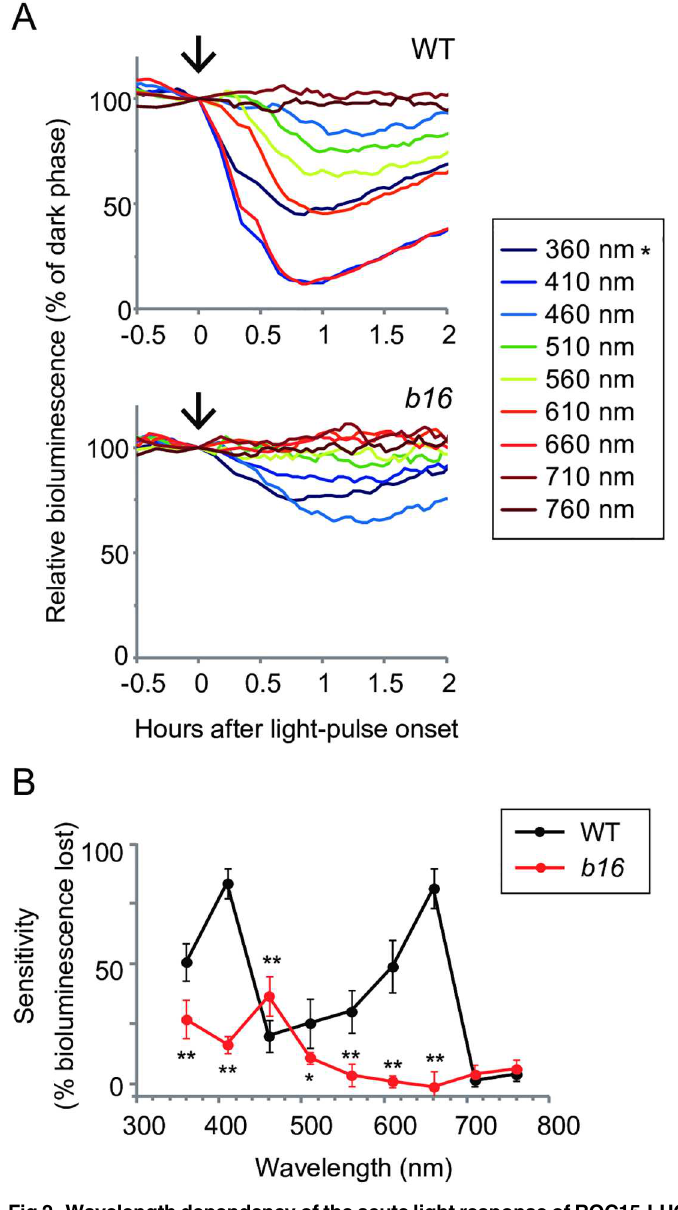
Fig 2. Wavelength dependency of the acute light response of ROC15-LUC. Asynchronous TAP cultures of WT and b16 cells in black 24-wellplates were subjectedto darknessfor 3 h for accumulationof ROC15-LUC, and then light pulses were administered. (A) Representative traces of the responseto various light qualities. 5 min light pulses were administered by a tunablemonochromatic light source. Each monochromatic light was given at 0.5 μ mol (cid:1) m -2 (cid:1) s -1 at the surface of the culture plates (arrows). Note that the 360 nm light ( * ) was weaker than those of other wavelengths at the sample level becausethe lid of culture plates blocked30% of 360 nm light. The bioluminescence level just before light pulse was set to 100. (B) Sensitivities of ROC15-LUCto light. The sensitivity was representedas the relative bioluminescence level lost after light pulse at the time point when the minimum bioluminescence was detected. Each point represents the mean ± SD of 4–6 independentcultures. * P < 0.05, ** P < 0.01 (Student’s t -test).